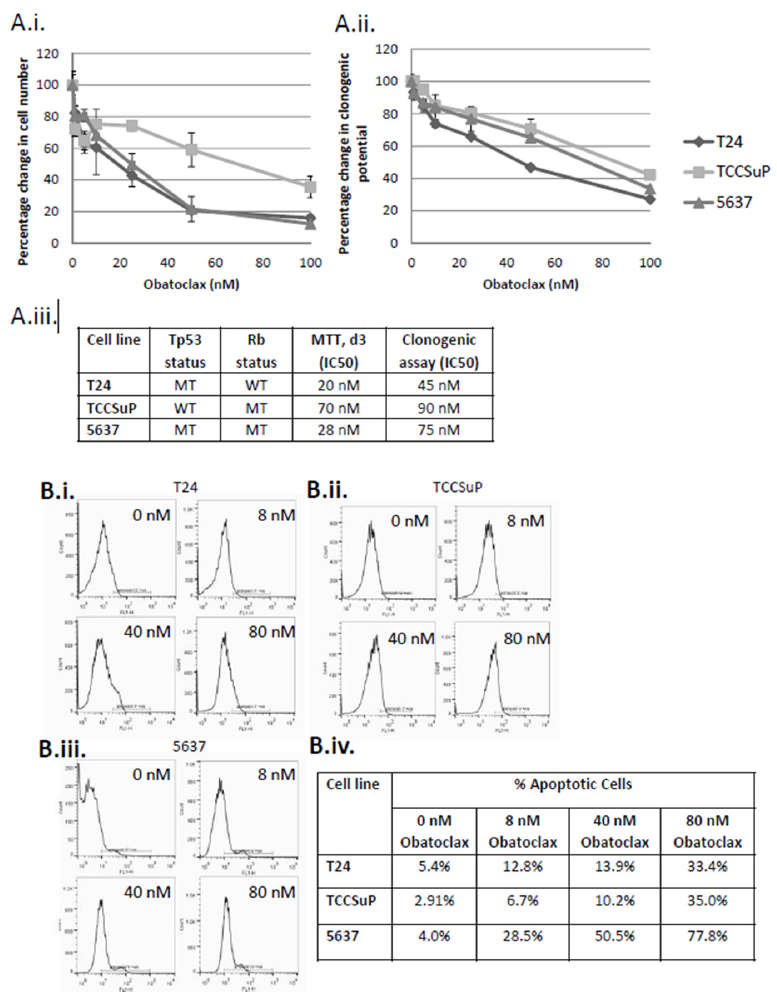
Figure 1. Obatoclax inhibits proliferation and clonogenic potential and promotes apoptosis of muscle invasive bladder cancer cells in a dose-dependent manner. Treatment of T24, TCCSuP, and 5637, muscle invasive bladder cancer (MI-BC) cells with Obatoclax mediated a dose-dependent decrease in cell proliferation ( A.i ) and clonogenic potential ( A.ii ). T24 cells, which harbor a Tp53 mutation, were